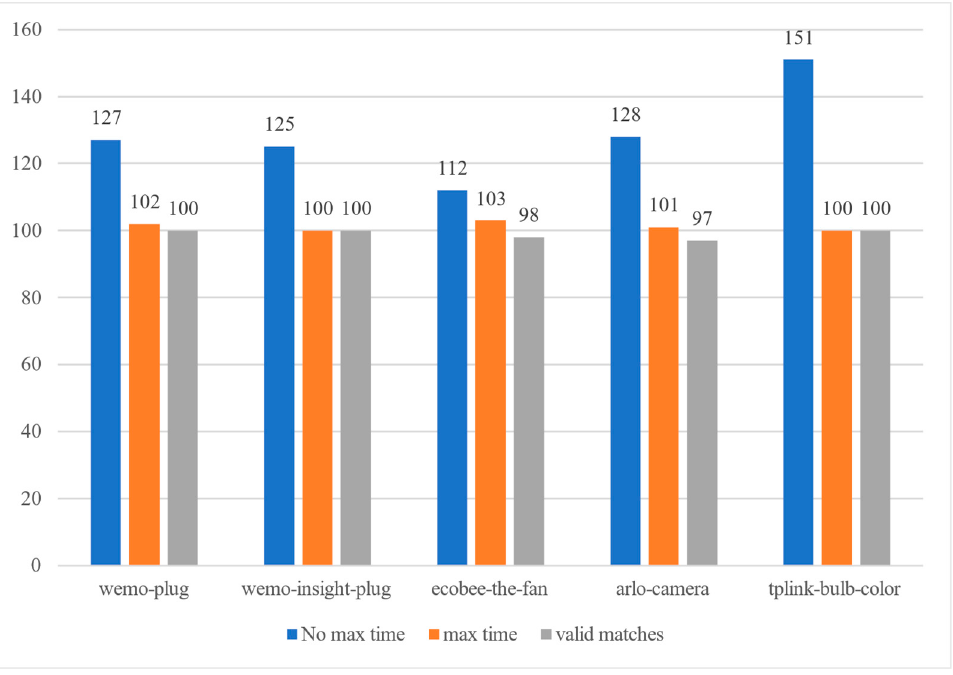
Figure 11. Max_time parameter experiment.